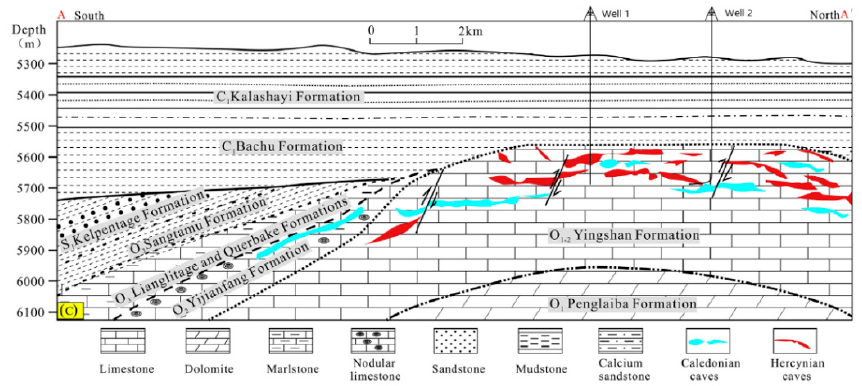
Figure 1. Location of the study area and overview map of the Tarim Basin. ( a ) Tectonic components of the Tarim Basin, including three uplifts and four depressions with east-west orientations (reference [31]). Tahe oilfield is located in the Northern Uplift of the Tarim Basin. ( b ) The study area is in the center of the Tahe oilfield, which is located in the southwestern part of the Akekule Arch in the Northern Uplift of the Tarim Basin (reference [31]). ( c ) Cross Section A-A’, showing the paleokarst system of the Tahe Oilfield. The main reservoirs are located in the northern part of the Tahe Oilfield in the Yingshan Formation (O 1–2 ys), which is at depths exceeding 5500 m (reference [31]). See Figure 1b for the cross-section